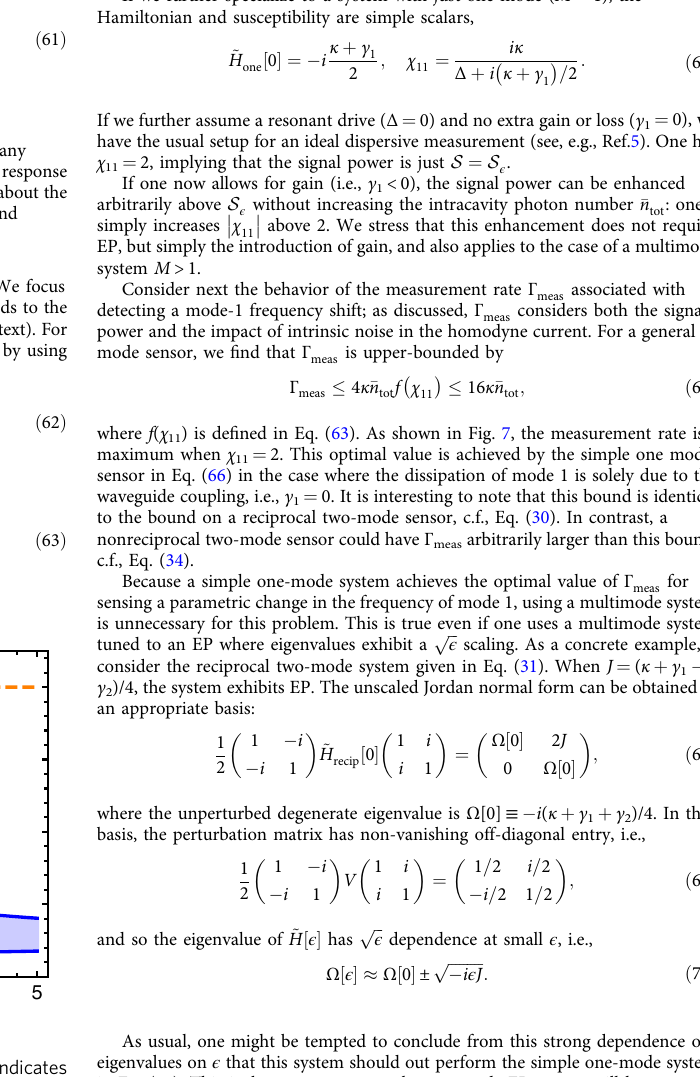
(cid:11) (cid:11) (cid:11) (cid:11) . f ( χ 11 ) sets the 11 (cid:11) (cid:11) (cid:11) (cid:11) (cid:9) 5, f ( χ 11 ) < 11